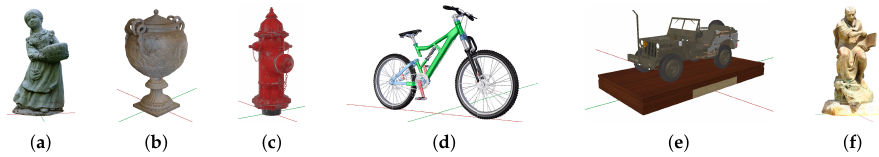
Figure 4. 3D models used for synthetic dataset generation and Ignatius ground truth: ( a ) Statue [67]. ( b ) Empire Vase [68]. ( c ) Hydrant [70]. ( d ) Bicycle [69]. ( e ) Jeep [71]. ( f ) Ignatius